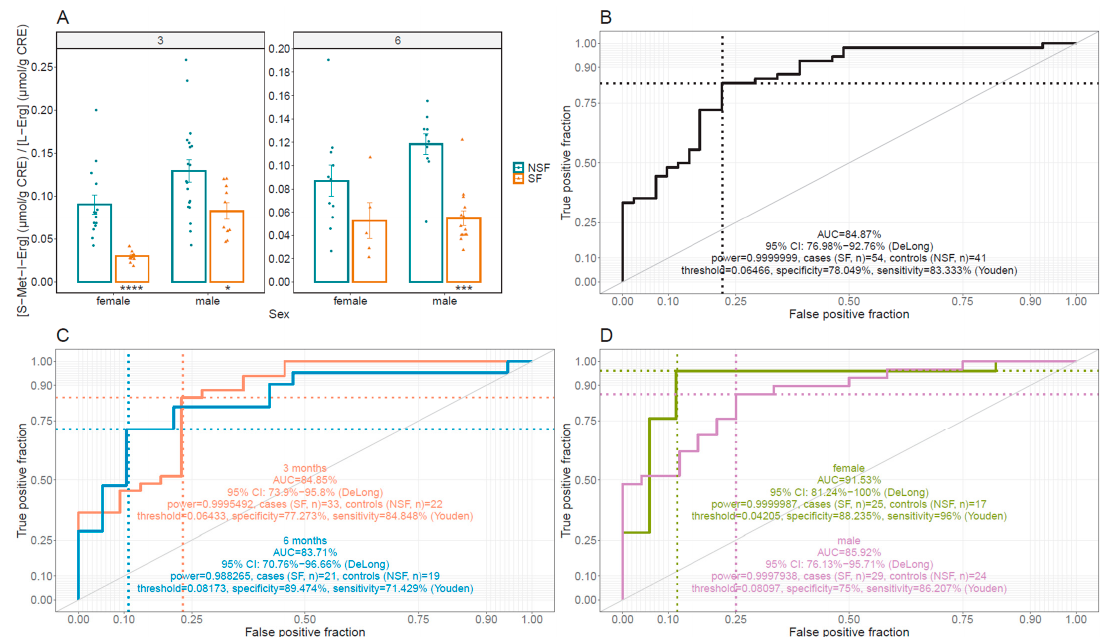
Figure 5. Urinary S-Met-L-Erg/L-Erg ratio in cystinuric ( Slc7a9 − / − ) mice. ( A ) Urinary S-Met-L-Erg/L-Erg ratio in stone former (SF, orange) and non-stone former (NSF, green) Slc7a9 − / − mice stratified by age (in months) and sex. Each dot represents a sample (the number of mice per condition ranges from 5 to 19), and the bars indicate the mean ± SEM. Mann-Whitney probability test values are indicated below the bars as *, p ≤ 0.05, ***, p ≤ 0.001, ****, p ≤ 0.0001 vs. non-stone former mice. ( B ) Receiver operator characteristic (ROC) curve displaying the performance of the Urine S-Met-L-Erg/L-Erg ratio distinguishing SF from NSF. ( C ) Receiver operator characteristic (ROC) curve displaying the performance of the Urine S-Met-L-Erg/L-Erg ratio distinguishing SF from NSF, stratified by age. ( D ) Receiver operator characteristic (ROC) curve displaying the performance of the Urine S-Met-L-Erg/L-Erg ratio distinguishing SF from NSF, stratified by sex. In all ROC curves, AUC, Area Under the Curve, CI, Confidence Interval.